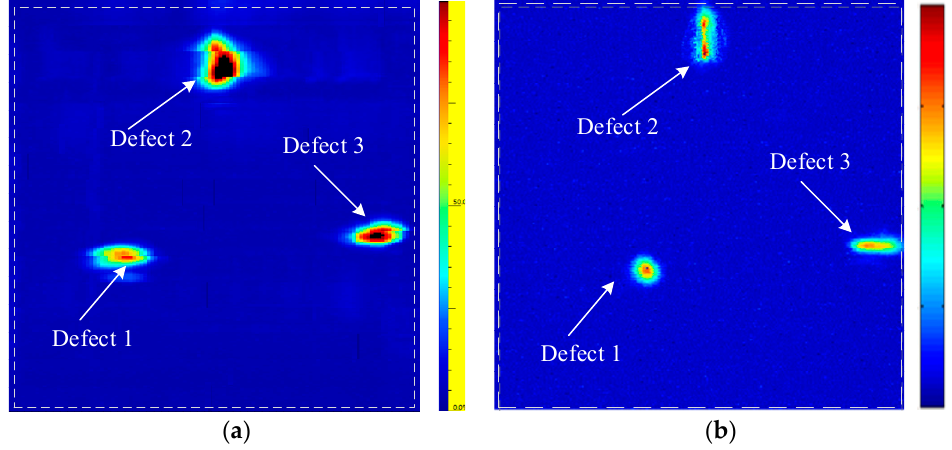
Figure 8. A comparison of linear array and annular array inspection results (the printing surface). ( a ) The linear array C-scan image using the conventional dynamic depth focusing (DDF) method. ( b ) The annular array C-scan image using the TFM.